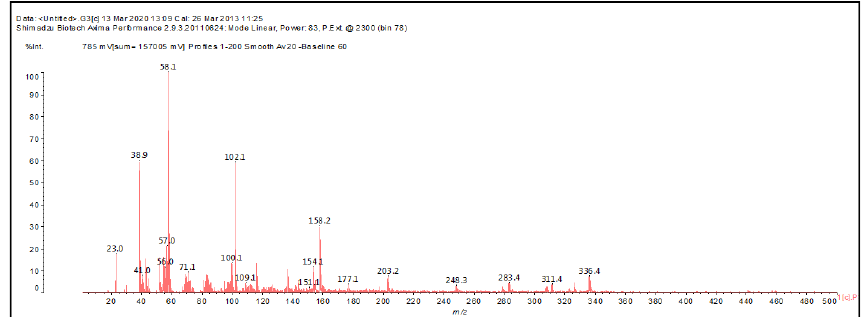
Figure 1. Matrix assisted laser desorption ionization time-of-flight spectrometry (MALDI ToF) spectrum of humins obtained at 180 °C from fructose, 20 – 500 Da range.